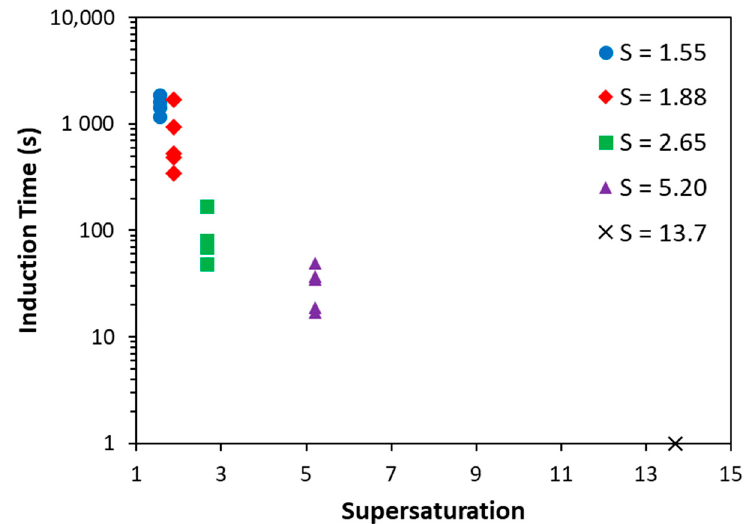
Figure 4. The measured induction times for the antisolvent crystallisation of lovastatin from an acetone/water solvent mixture (90:10 wt.%) at 25 °C as a function of supersaturation. There are five data points for S = 13.7, but they all overlap, as they are the same ( ≤ 1 s).